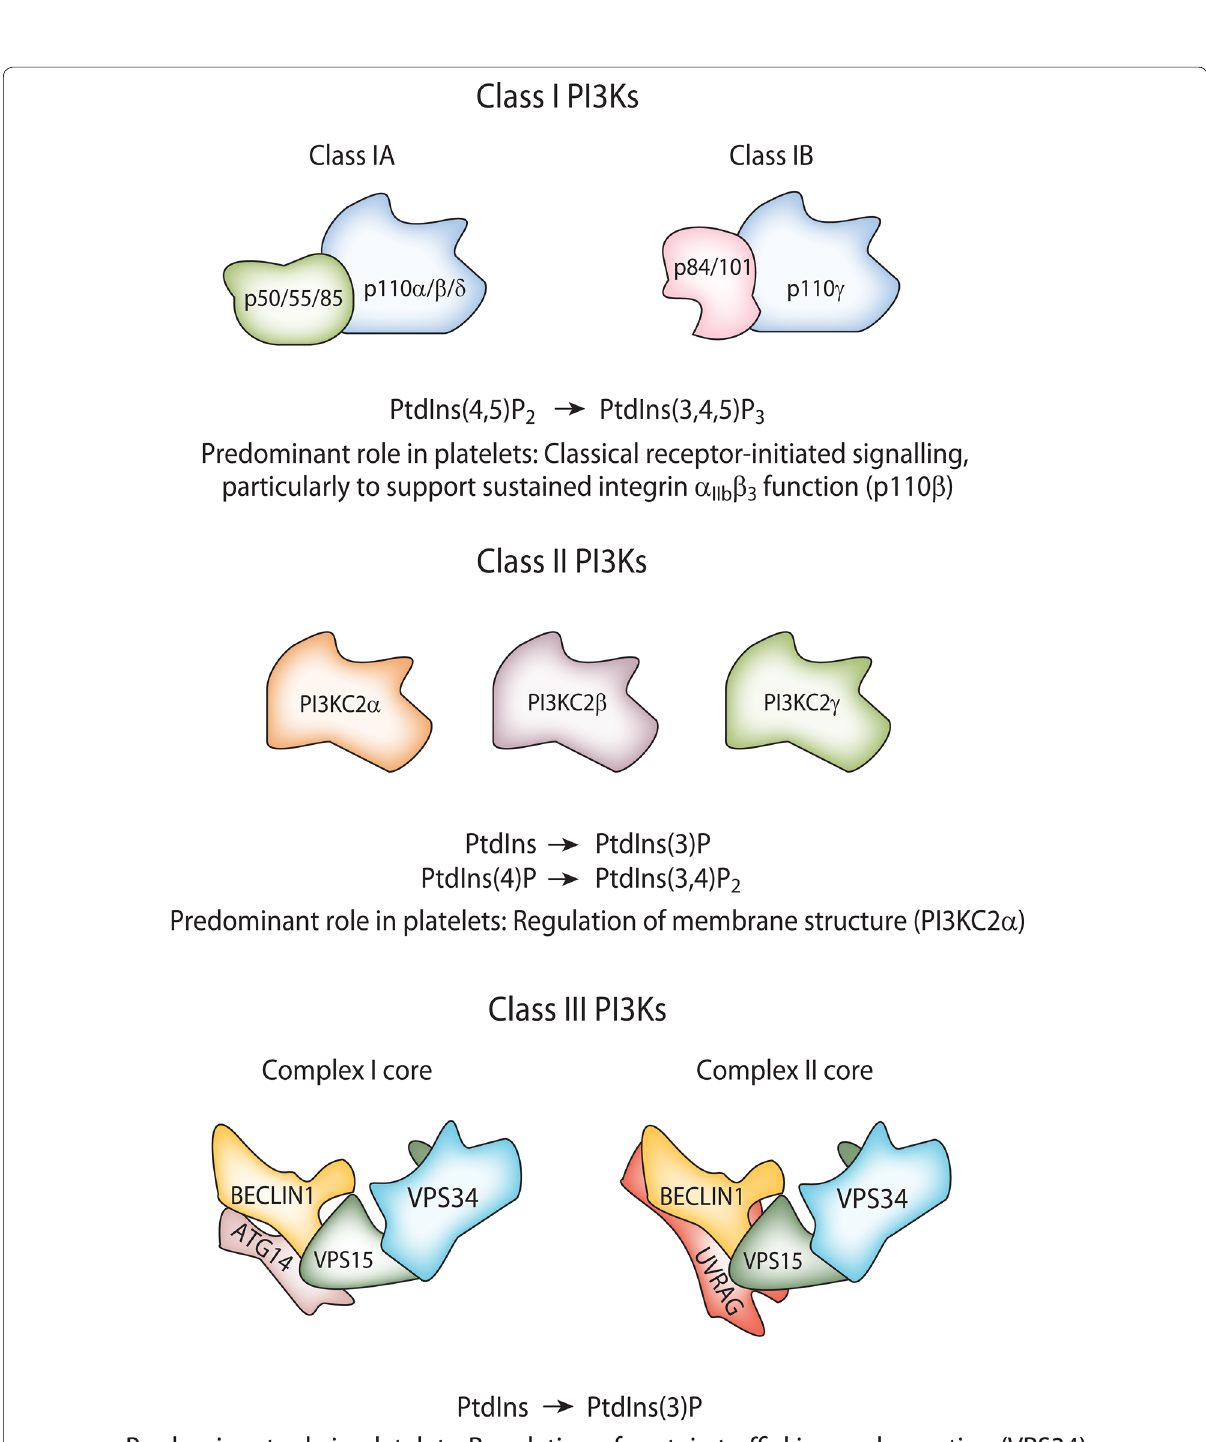
Fig. 2 Overview of the PI3K complexes and their activities. Class I PI3Ks form heterodimers comprised of a catalytic subunit and a regulatory subunit, although free Class IA regulatory subunits also exist in cells. In vivo, Class I PI3Ks 3-phosphorylate PtdIns(4,5)P 2 to generate PtdIns(3,4,5) P 3 . Class II PI3Ks appear to function as independent catalytic subunits, and are currently considered to 3-phosphorylate PtdIns and PtdIns(4)P in vivo to yield PtdIns(3)P and PtdIns(3,4)P 2 , respectively. However, Class II PI3K-deficient mouse models suggest PI3KC2α may only act to regulate a housekeeping pool of PtdIns(3)P in platelets, while PI3KC2β has no clear functional role, and PI3KC2γ is not expressed in this cell type. Class III PI3K, VPS34, associates with various proteins to form at least two known complexes, although it is likely that other associations and complexes exist. Class III PI3K phosphorylates PtdIns to generate PtdIns(3)P. Class I, II and III PI3Ks all play roles in platelet thrombus formation, and the predominant role of each is